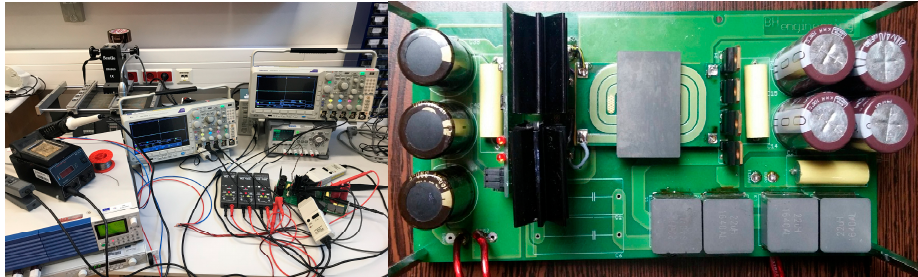
Figure 10. Measurement set-up ( left ) and experimental sample ( right ) of the proposed converter designed for 1 kW peak of output power.